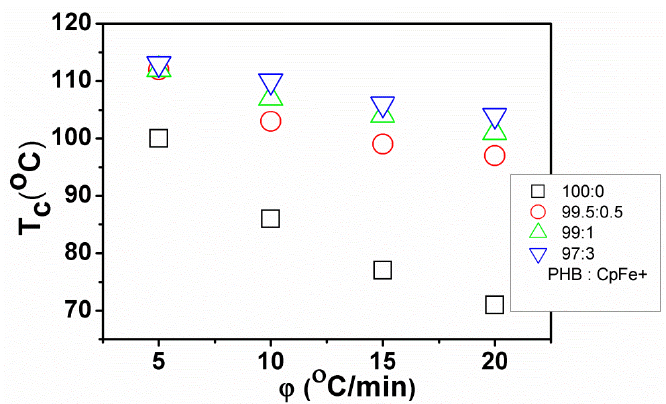
Figure 7. A maximum crystallization temperature as a function of a cooling rate for the non-isothermally crystallized pure PHB and PHB/ CpFe+ nanocomposites.